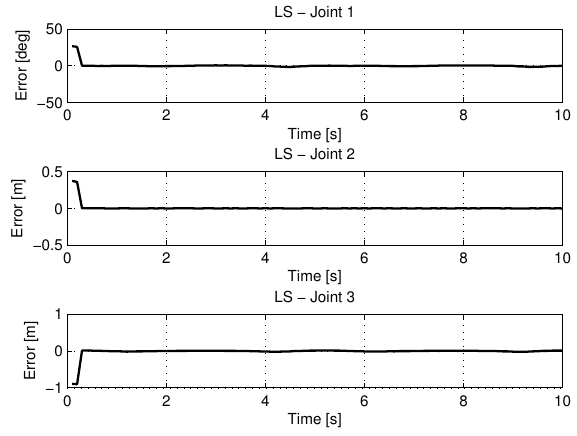
Figure 7. Error of Trajectories identifications with LS.